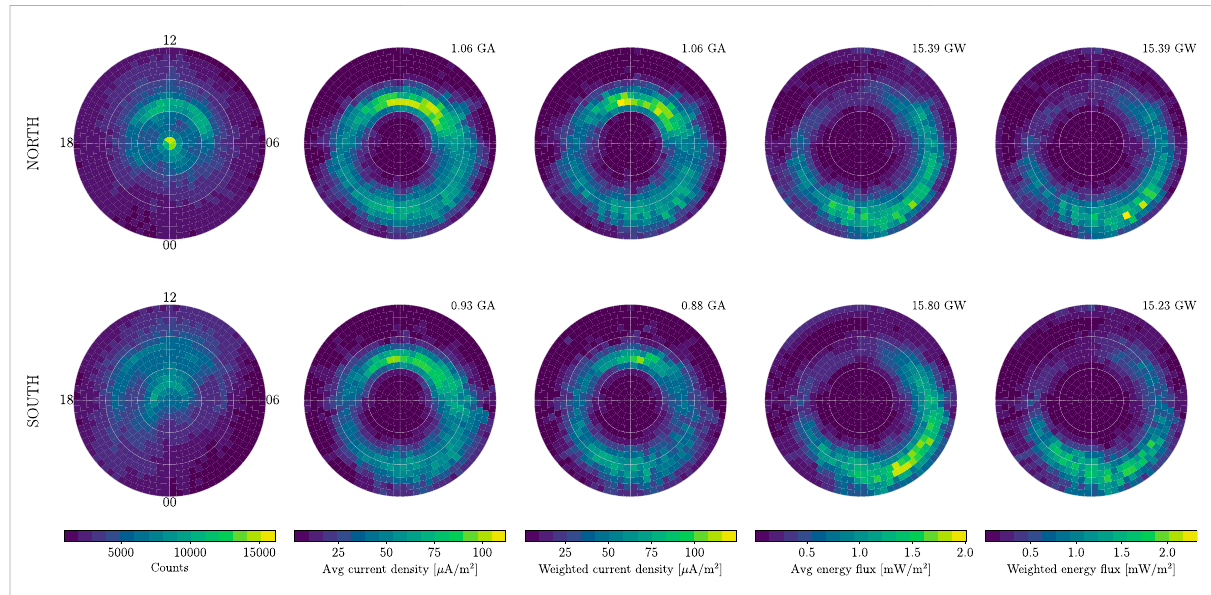
FIGURE 13 FAST electron loss-cone precipitation statistics in the Northern and Southern Hemisphere (top and bottom row, respectively) during local winter. The fi rst column shows the number of measurements in each hemisphere. The second and third columns show the longitude-biased and unbiased average current density, respectively. The fourth and fi fth columns show the longitude-biased and unbiased average energy fl ux. Statistics are calculated on an approximately equal-area MLat-MLT